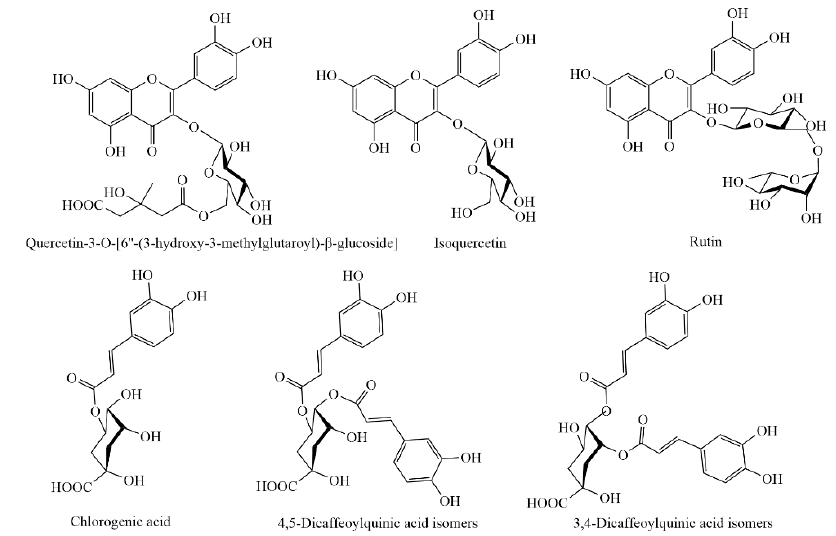
Figure 1. Main polyphenolic compounds identified in P. angustifolium leaves and stem.